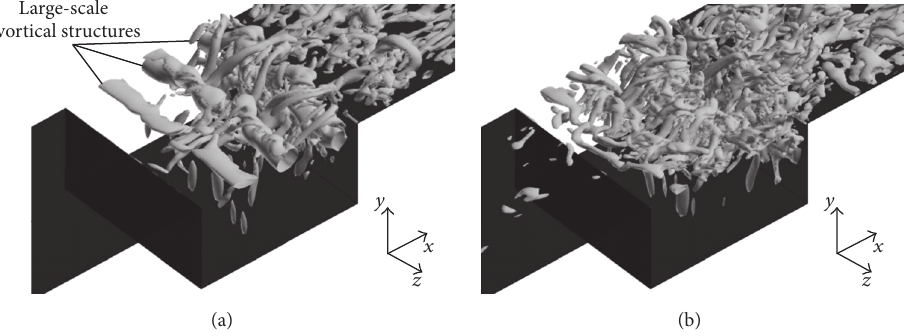
Figure 15: Instantaneous isosurfaces of second invariant of velocity tensor gradient (𝑞/(𝑈 ∞ /𝐿) 2 = 20) for cavity flows without acoustic resonance ( 𝐷/𝐿 = 0.5). (a) Cavity flow without freestream turbulence (Tu = 0.0%). (b) Cavity flow with freestream turbulence, Tu = 2.3%.